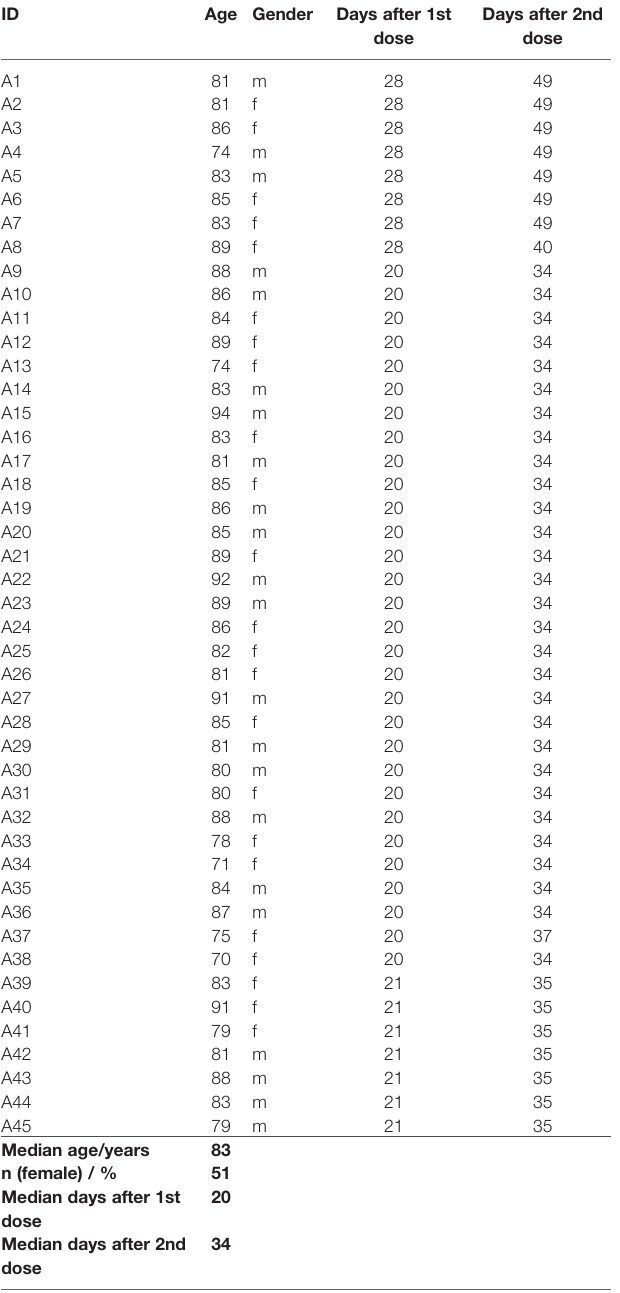
TABLE 1 | Characteristics from individuals older than 70 years vaccinated with BNT162b2 included in the study (n =